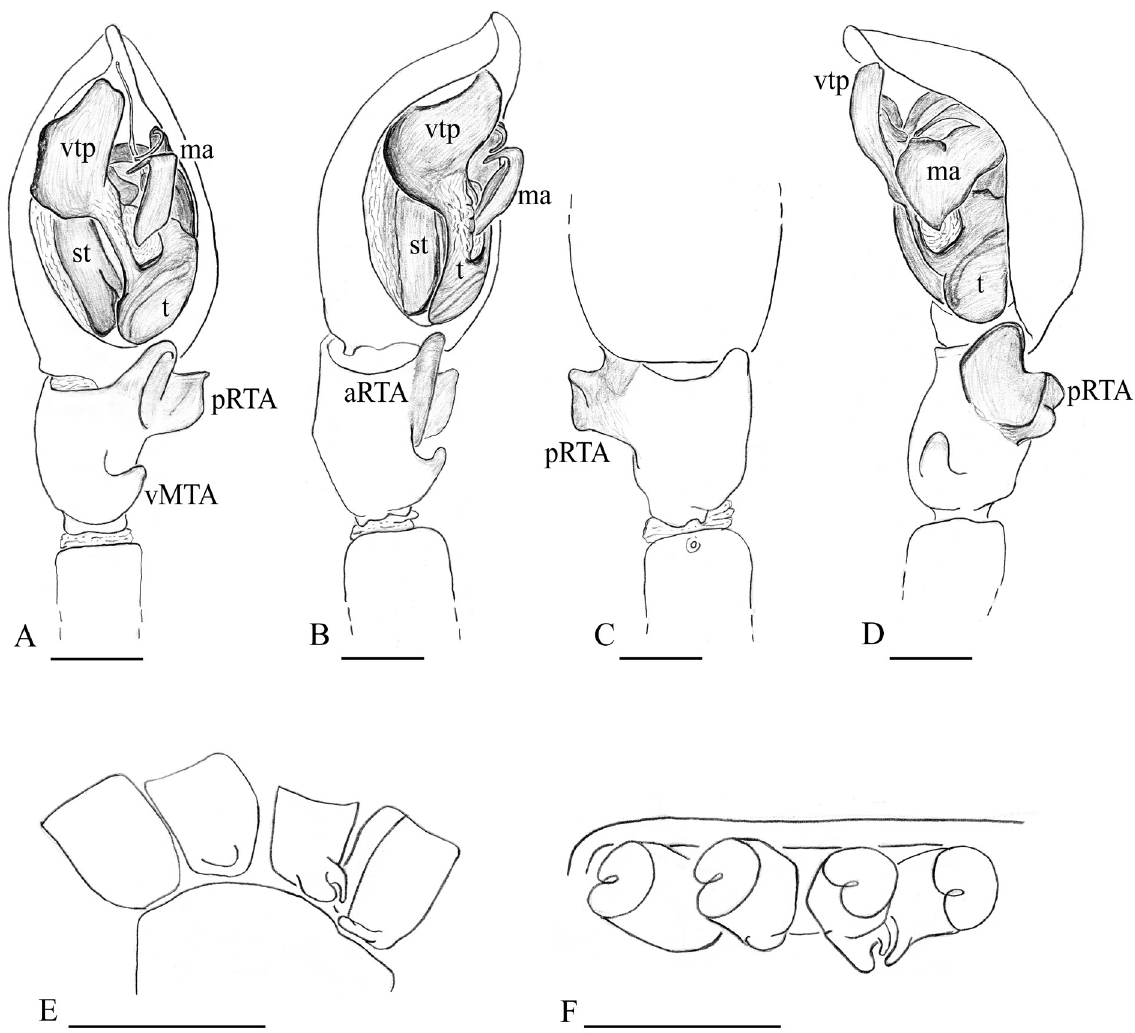
Fig. 35. Anyphaena quadrata sp. nov., paratype, ♂ (CNAN-T01566). A . Pedipalp, ventral view. B . Pedipalp, prolateral view. C . Pedipalp, dorsal view. D . Pedipalp, retrolateral view. E . Coxae, ventral view. F . Coxae, lateral view. Scale bars: A–D = 0.2 mm; E–F = 1.0